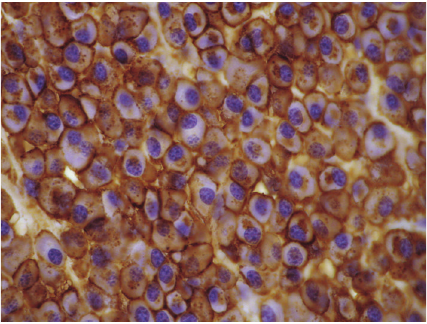
Figure 2: Monomorphic population of atypical plasma cells.